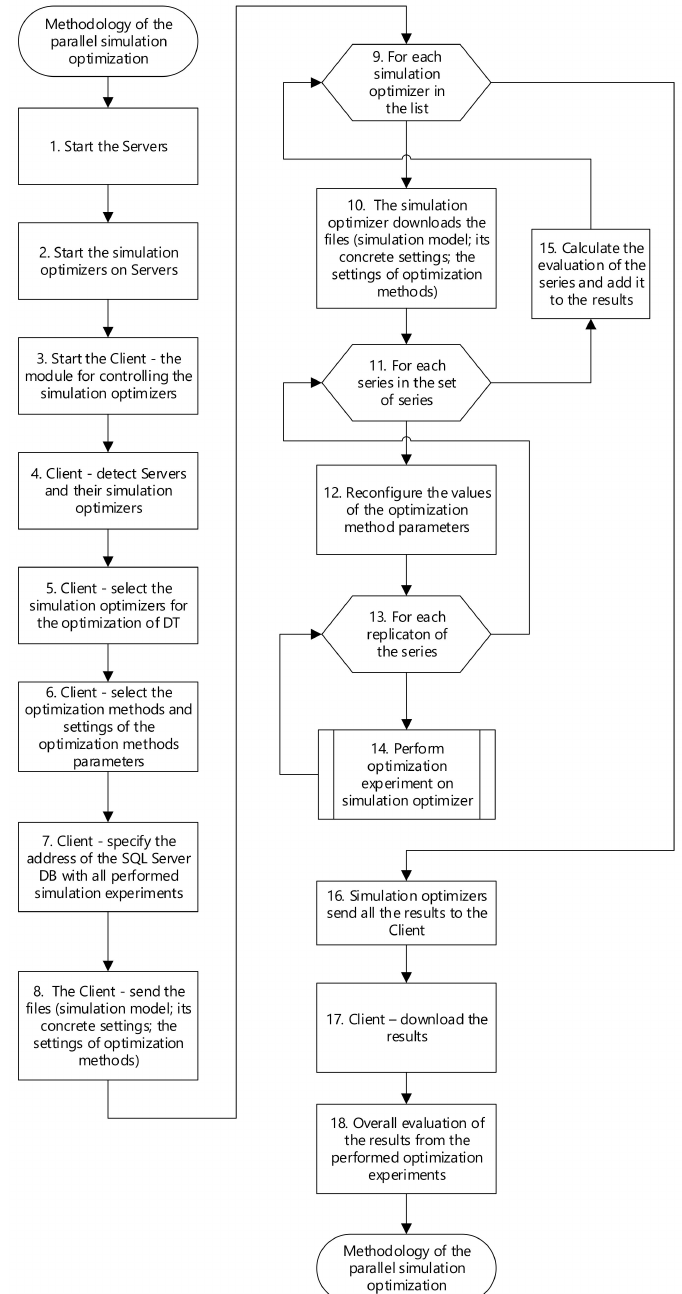
Figure 7. Flowchart of methodology of the parallel simulation